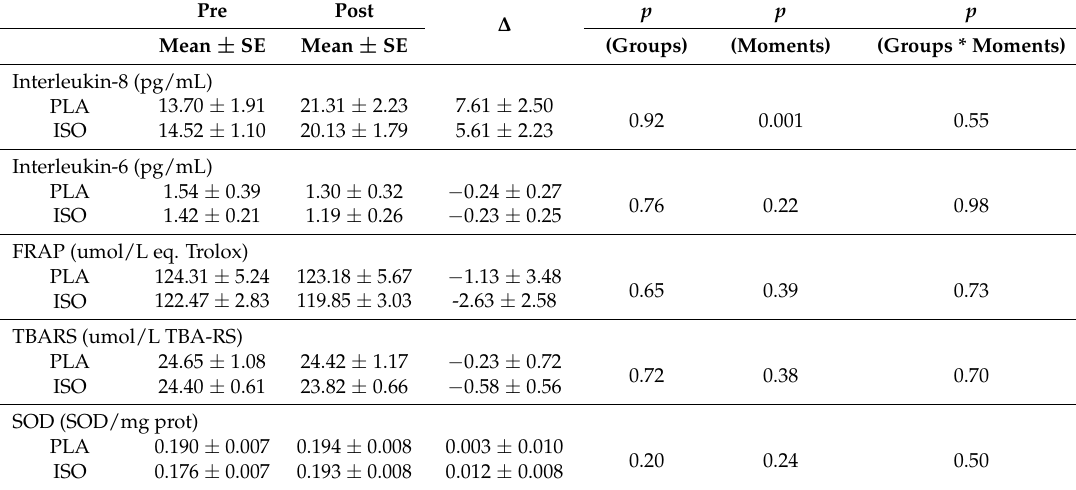
Table 2. Comparison of inflammatory and oxidative stress markers in the pre and post intervention moments in the placebo (PLA) and isoflavone (ISO)